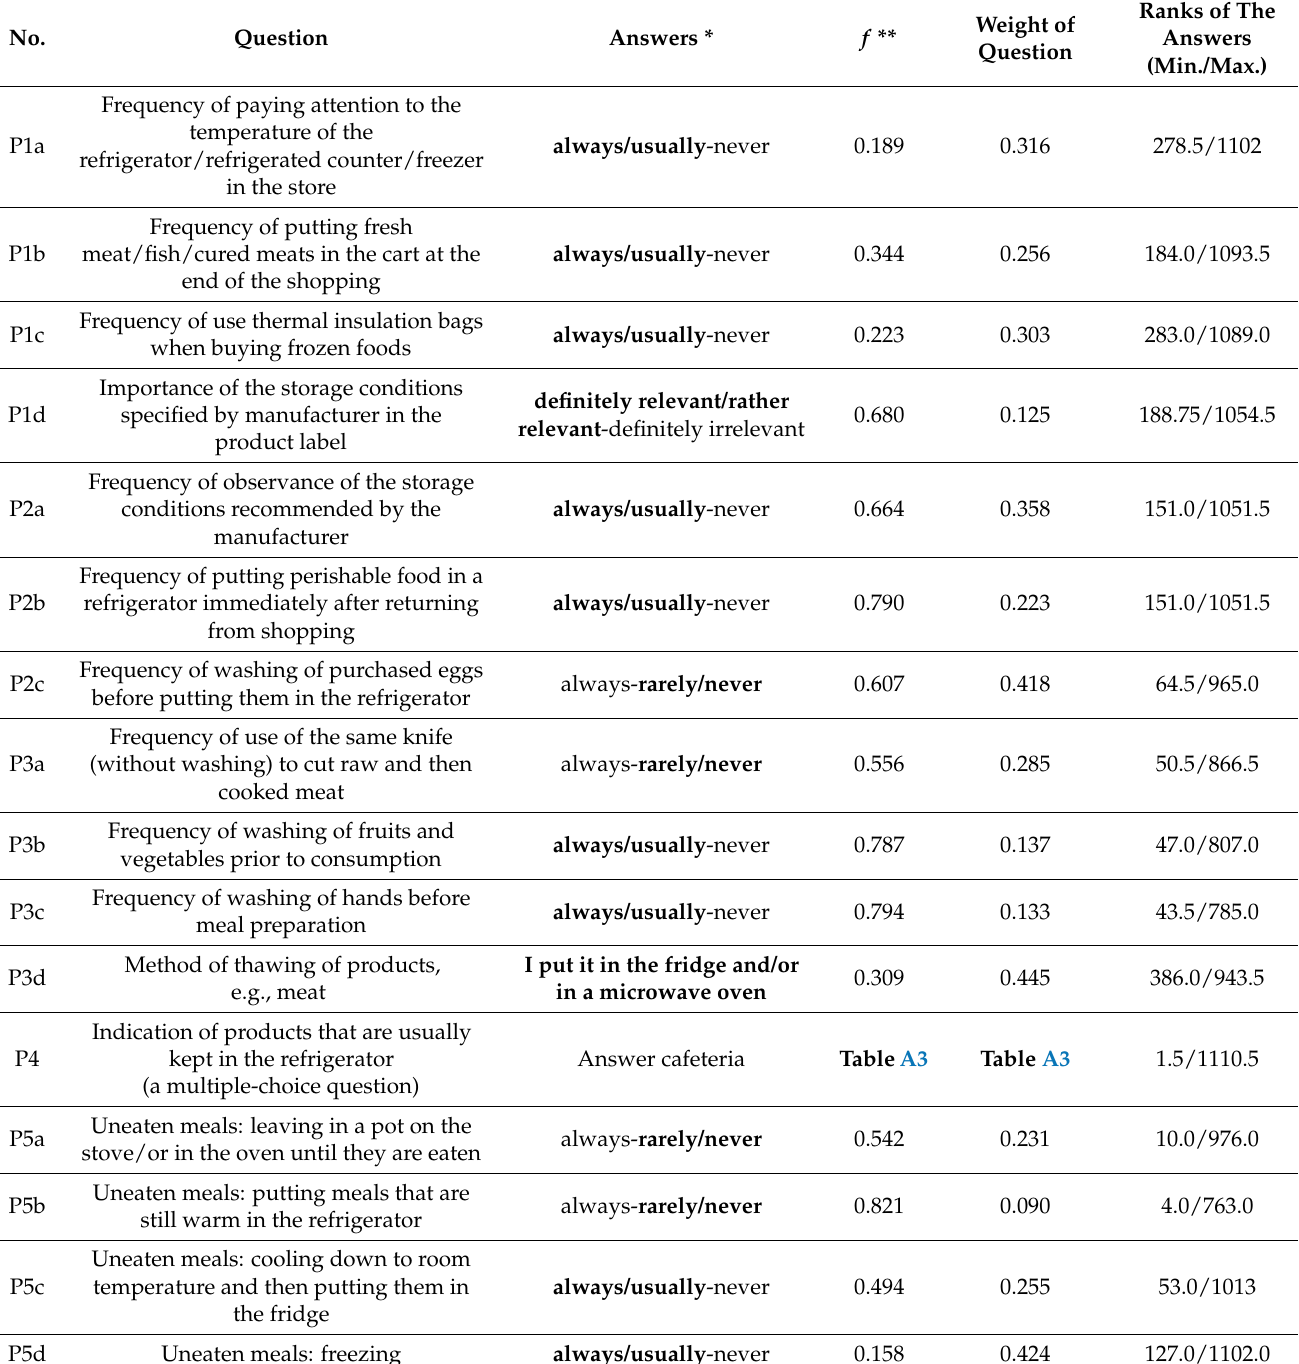
Table A2. A set of questions taken into account while constructing a synthetic variable concerning the practice along with the calculated weights and